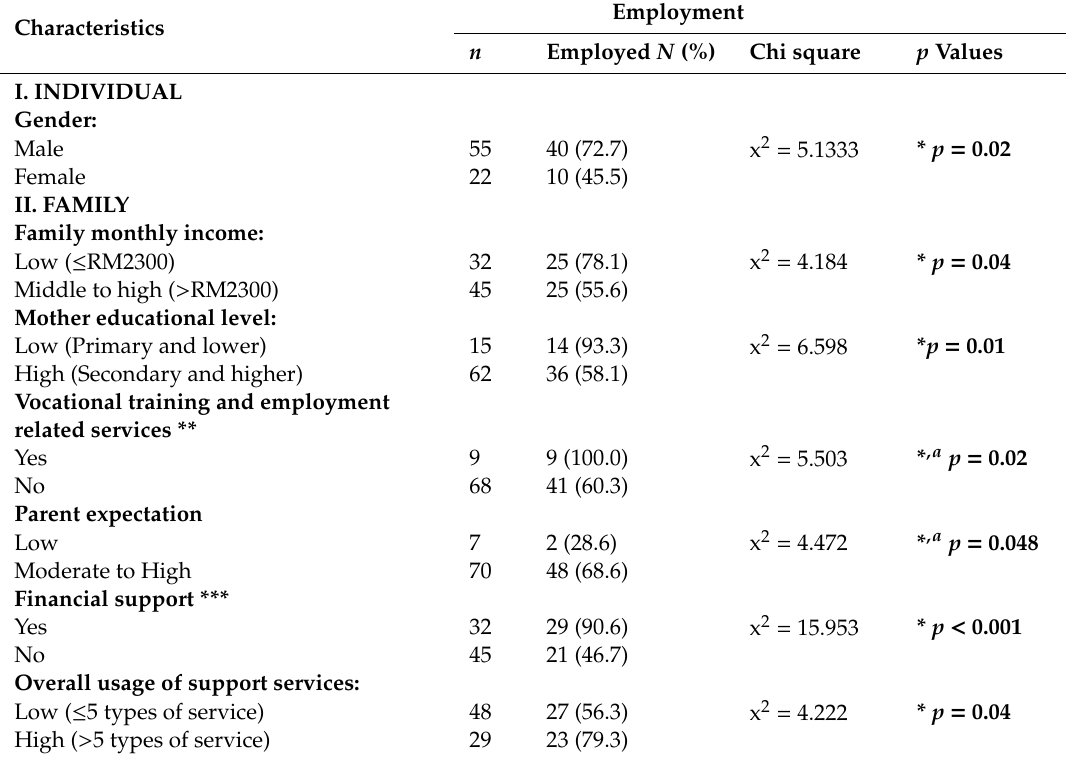
Table 3. Significant di ff erences in the prevalence of engagement in employment (n = 77). Characteristics